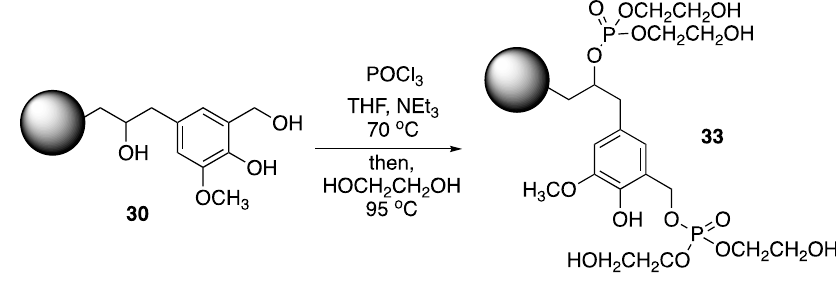
Figure 17. Preparation of lignin 33